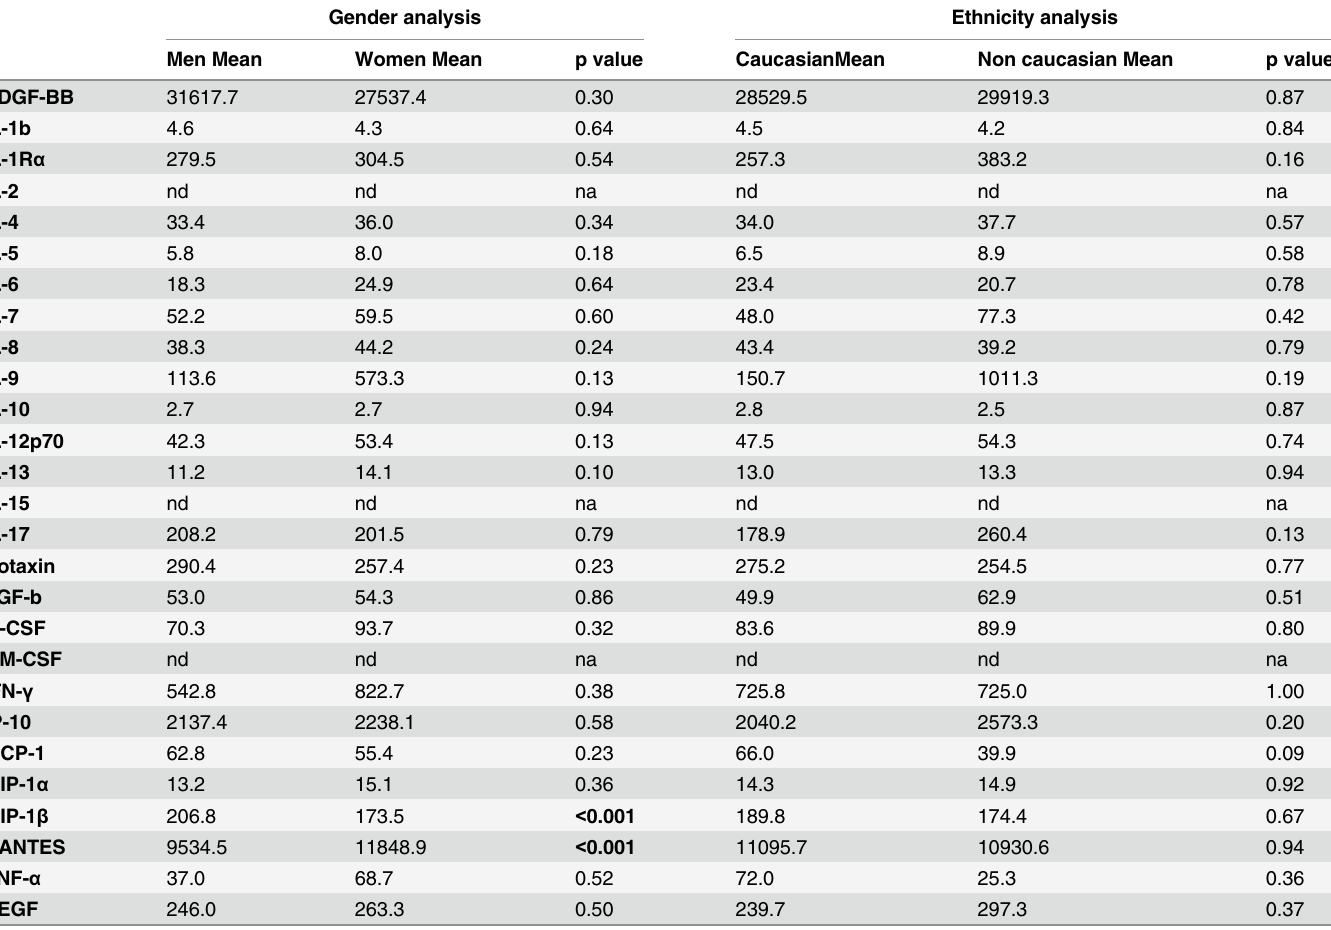
Table 2. Mean serum cytokine concentrations for Men and Women, and Caucasian vs Non